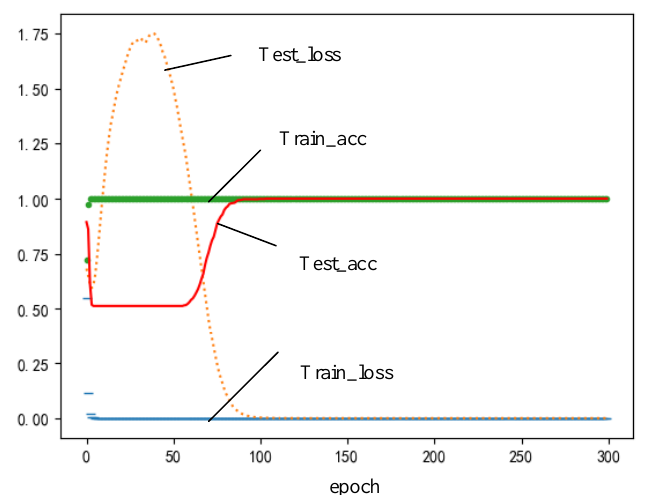
Figure 8. Training curve.